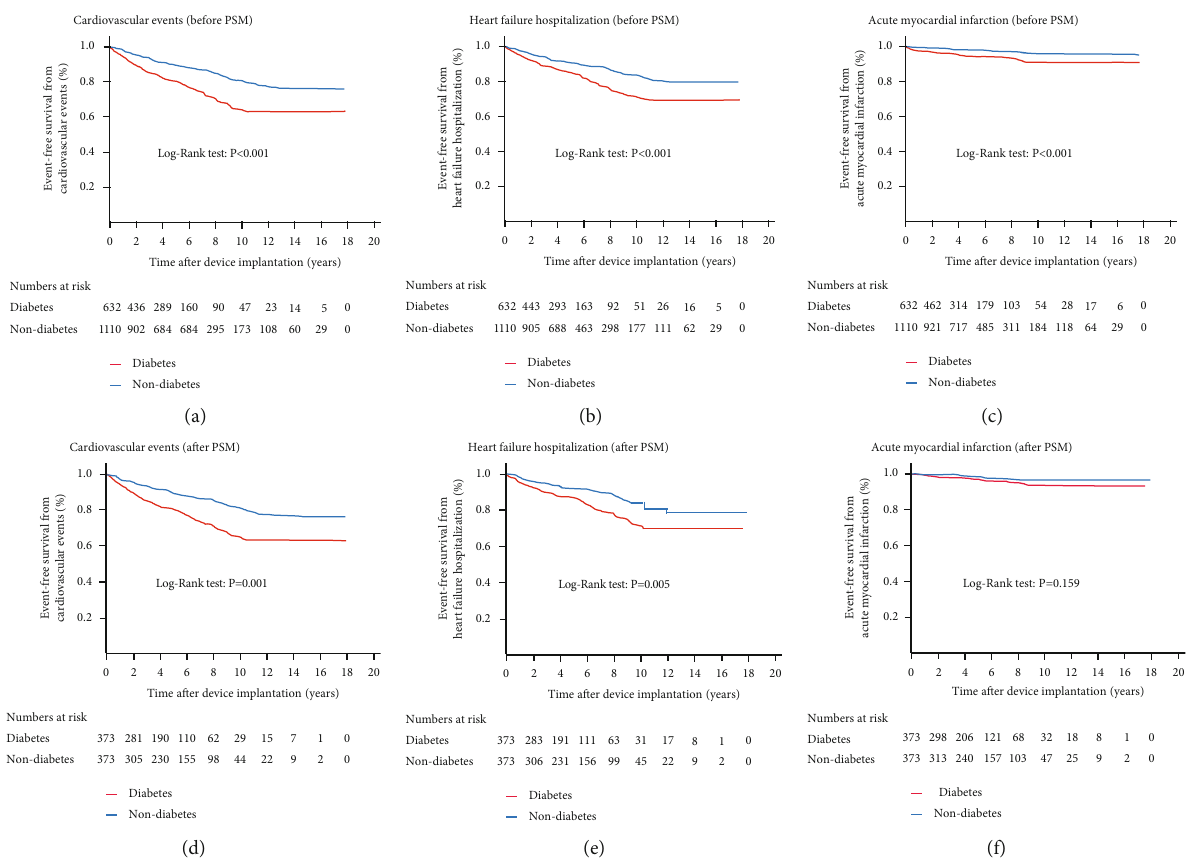
Figure 2: The Kaplan-Meier event-free survival curves of cardiovascular events (primary outcome) (a, d), heart failure hospitalization (b, e), and acute myocardial infarction (c, f) between the groups with and without diabetes before and after propensity score matching. PSM: propensity score